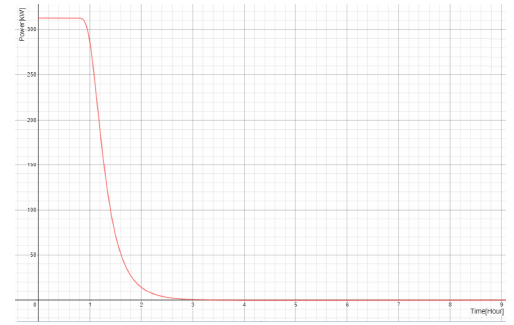
Figure 11. Special event occurrence.